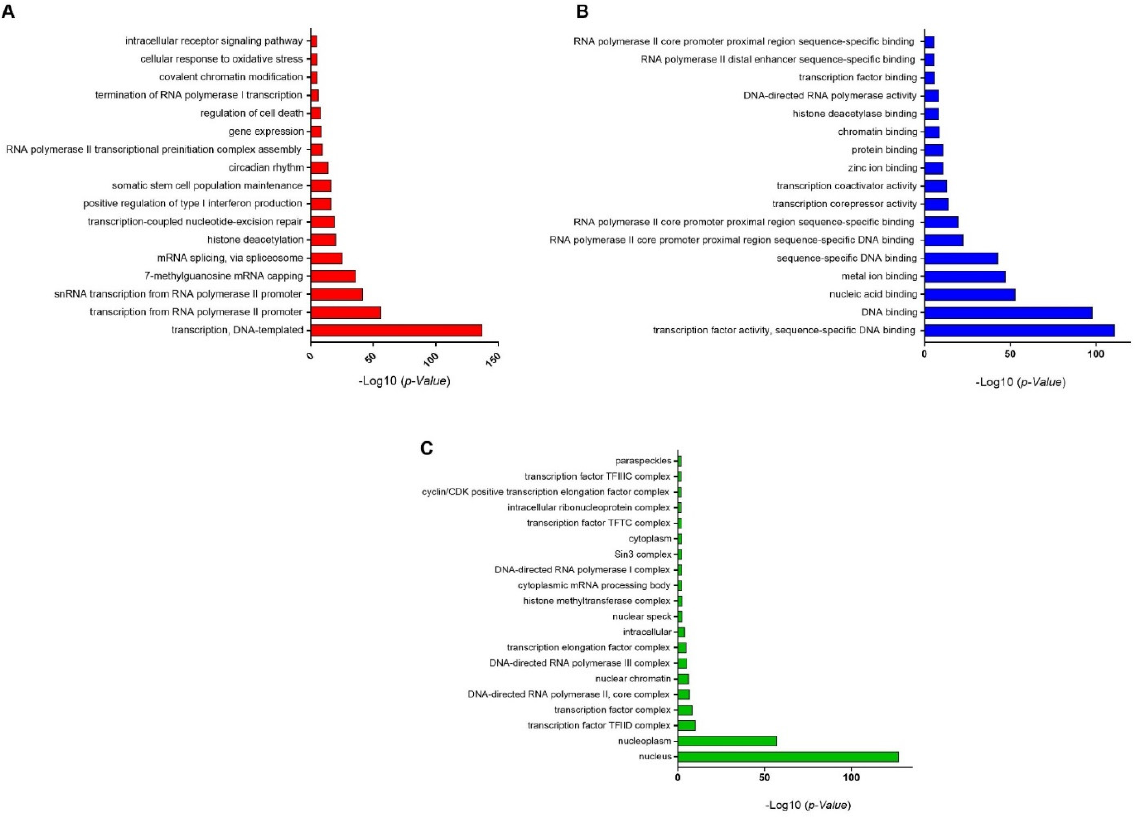
Figure 3. Gene ontology (GO) enrichment. Classification of the GO levels for upregulated transcription factors derived from a meta-analysis. Transcription factors were annotated in three classes: biological process ( A ), molecular function ( B ), and cellular component ( C ). The x-axis depicts -log ( p -value), and y-axis shows GO terms.